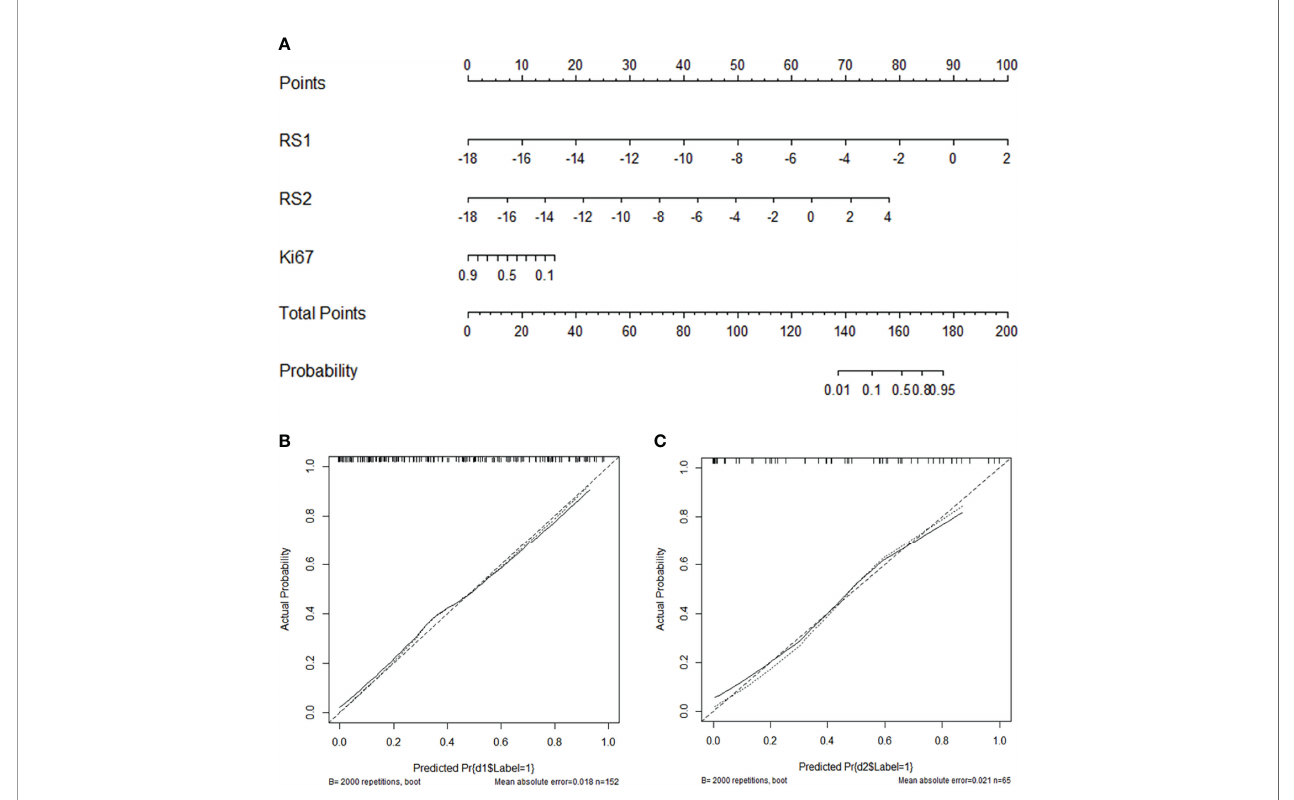
FIGURE 6 | Nomogram with the RS1, RS2, and Ki-67 incorporated (A) and calibration curves for the nomogram in the training (B) and validation groups (C)